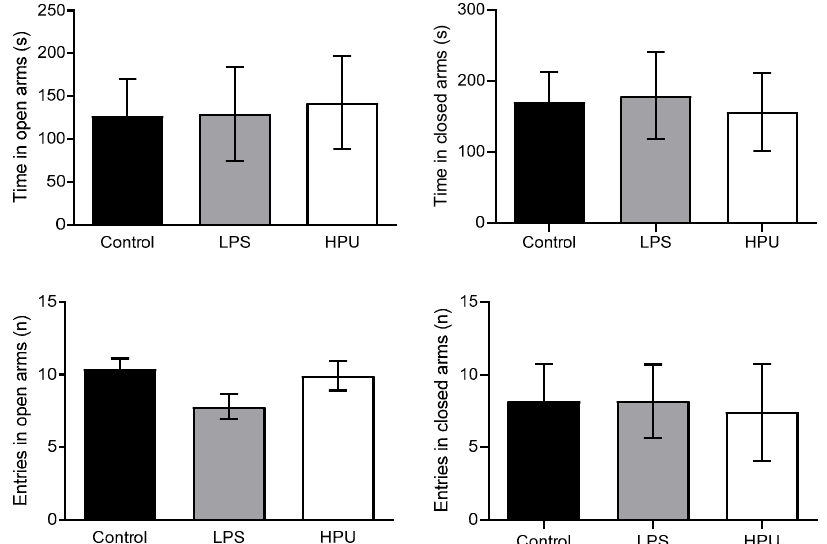
Figure 8. Elevated plus maze performance of HPU-treated rats. Male Wistar rats received i.p., injections of HPU (5 µg/rat/day), LPS (1 mg/kg/rat/day, positive control) or saline (negative control) for 7 days. Entries to open and closed arms of the elevated maze and time spent in each arm were measured. Data were analyzed by one-way ANOVA followed by Bonferroni’s multiple comparison test. Data expressed as median ± SEM. n = 10 rats/group.